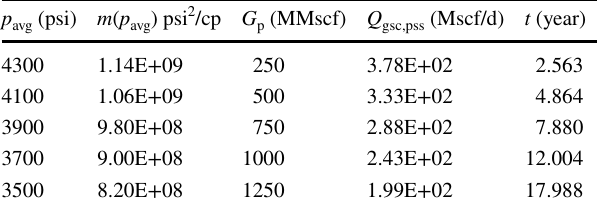
Table 4 Results of calculations of long-term post-fracturing produc- tion profile; late time radial flow pseudosteady